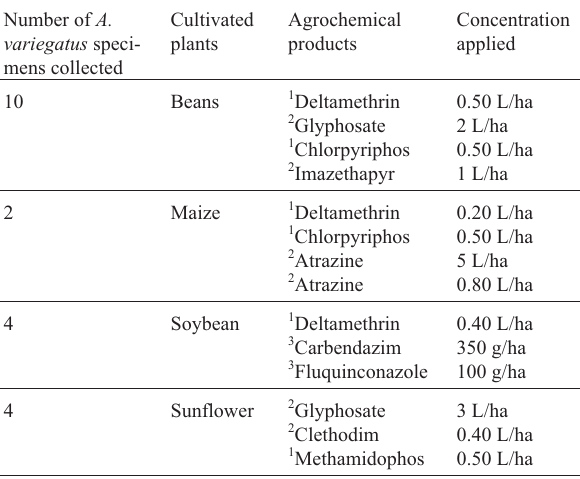
Table 1 - Specimens of Astylus variegatus collected in different crops in an agricultural area. Number of A. variegatus speci- mens